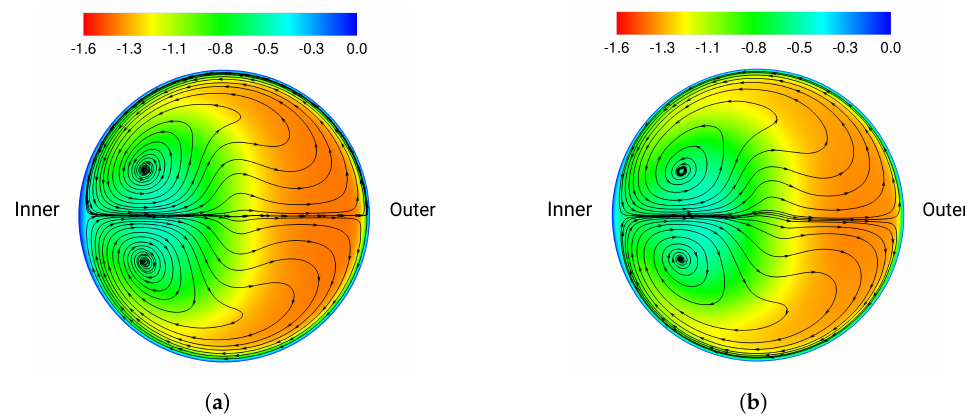
Figure 14. Time-averaged dimensionless downstream streamwise velocity (cid:104) v (cid:105) / U b and streamlines of the 90 ◦ cases in the x - z plane at y / D = − 1.5. ( a ) Re L . ( b ) Re H